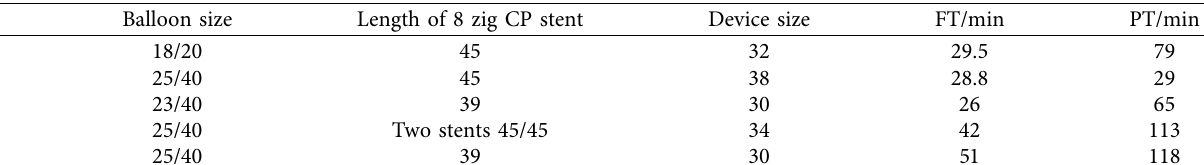
Table 3: Characteristics of the procedure.